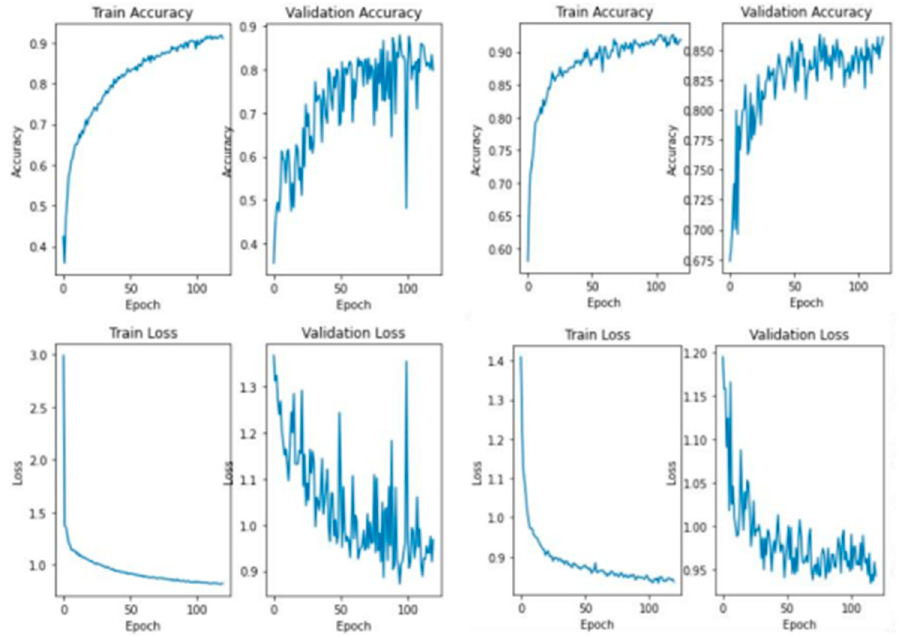
Figure A4. Training progress of the attention-based models: simple Vision Transformer ( left ) and pre-trained Vision Transformer ( right ).